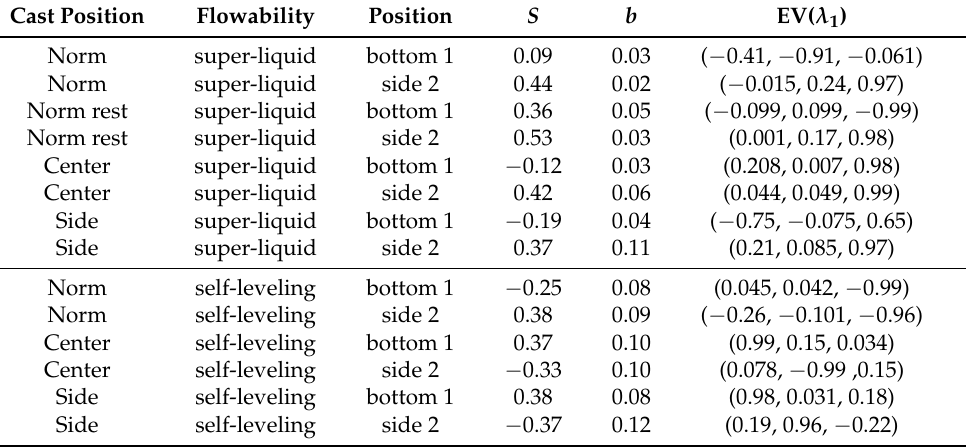
λ 1 ( | λ 1 | ≥ | λ 2 | ≥ | λ 3 | ), 2 (cid:104) (cid:105) | S | 0, 1 and S ∈ [ − 1 ,1 ] ; see [58]. S = 1 is 3 2 is planar isotropic; see 2